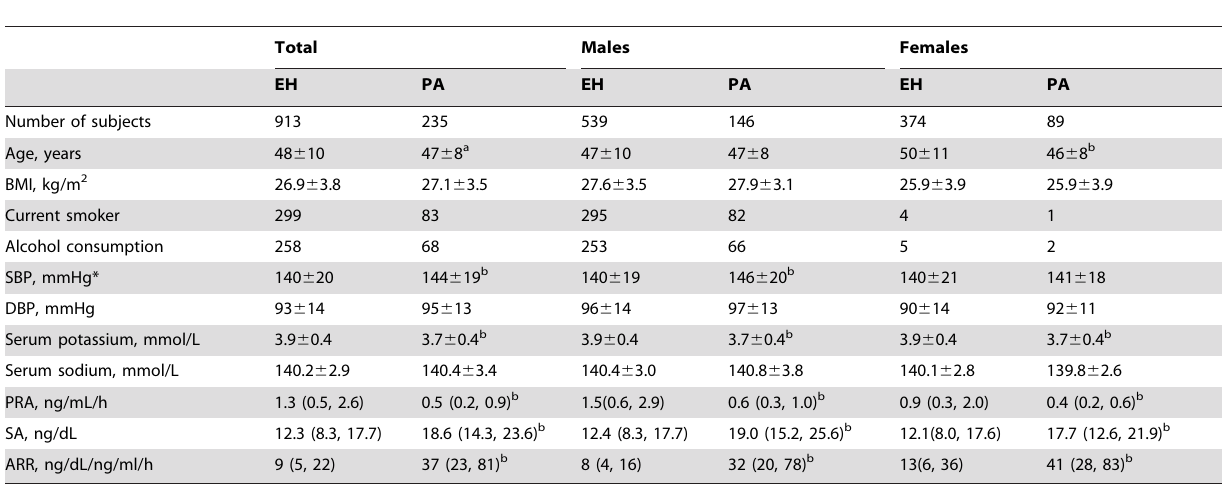
Table 1. Baseline characteristics of PA and EH